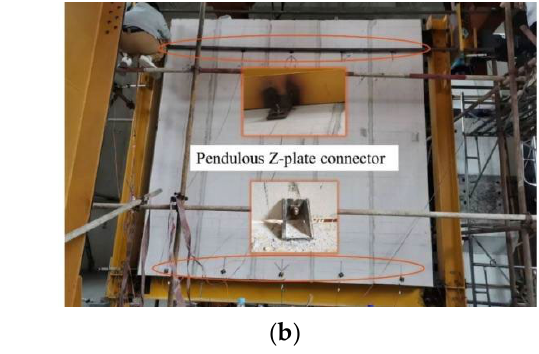
Figure 5. Test setups. ( a ) Specimens of DC. ( b ) Specimens DN.